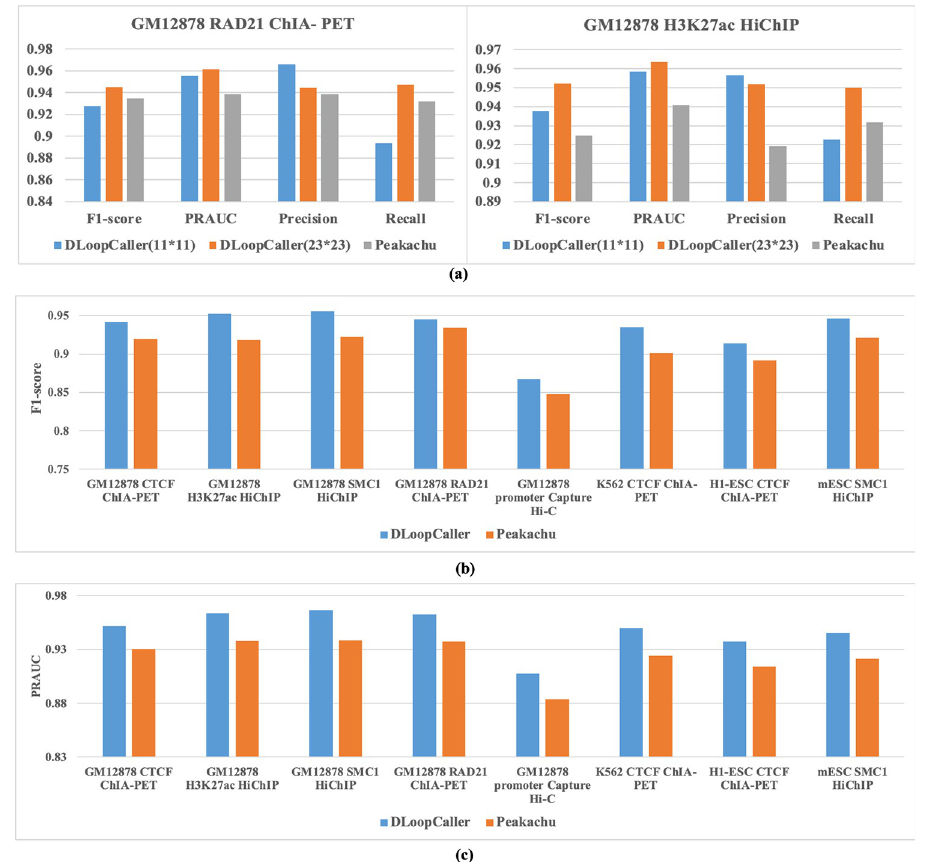
Fig 3. The overall performance comparison of DLoopCaller and Peakschu on different cell lines. (a) The F1-score, PRAUC, Precision and Recall values of RAD ChIA-PET and H3K27ac HiChIP in GM12878. (b)-(c): The F1-score and PRAUC values of CTCF ChIA-PET, H3K27ac HiChIP, SMC1 HiChIP, RAD ChIA-PET, and promoter Capture Hi-C in GM12878, CTCF ChIA-PET in K562 (replicate1) and H1-ESC, and SMC1 HiChIP in